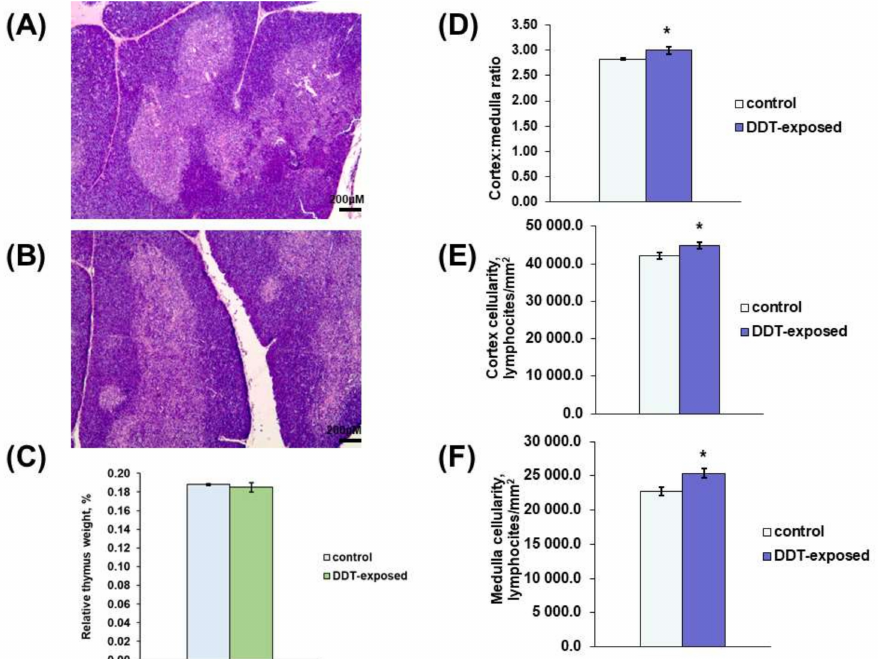
Figure 1. Morphology of the thymus of prenatally and postnatally exposed to DDT and intact adult rats aged 10 weeks. Histology of the thymus of the control ( A ) and DDT-exposed ( B ) rats. Magnification 50, scale bar 200 µ m. Relative thymus weight ( C ), cortex/medulla ratio ( D ), lymphocyte density of the cortex ( E ) and the medulla ( F ). Data are shown as mean ± S.E.M.; p < 0.05 compared to the control (*).